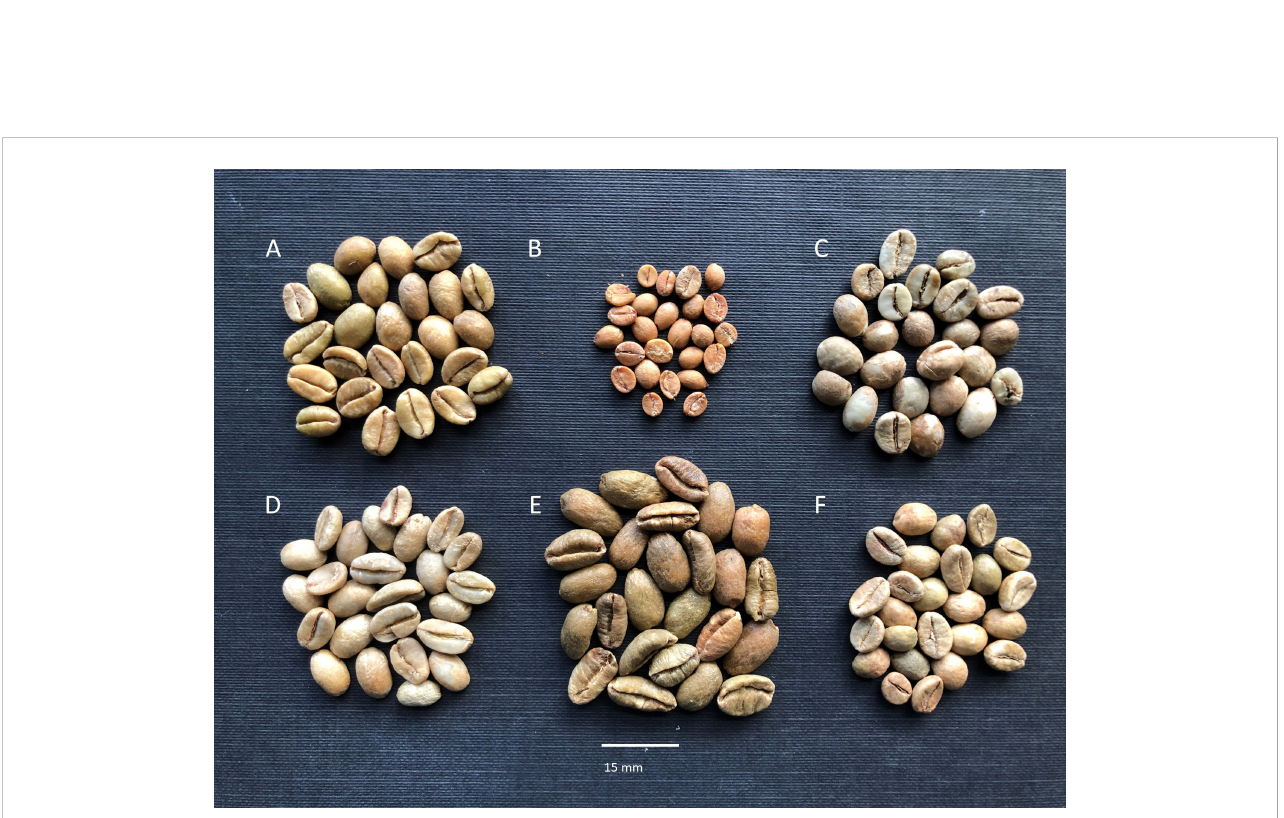
FIGURE 5 Seeds (unroasted coffee beans) of three Ugandan coffee species, with some cultivated species for size comparison. (A) C. liberica var. dewevrei (excelsa coffee), cultivated in central Uganda; (B) C. eugenioides , cultivated in Kampala, Uganda (1921), from RBG Kew Economic Botany Collection; (C) C. canephora (robusta coffee), cultivated in Uganda; (D) C. arabica (Arabica coffee), cultivated in Ethiopia; (E) C. liberica var. liberica (Liberica or Liberian coffee), cultivated in Malaysia; (F) C. canephora (robusta coffee), cultivated in India. Each sample comprises 25 seeds.